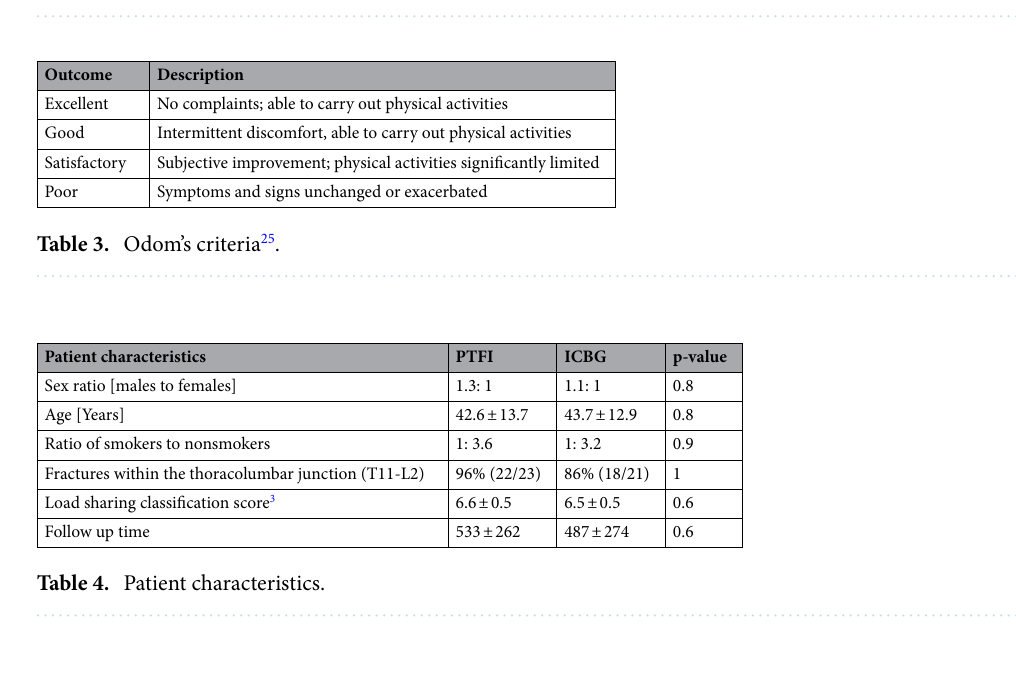
Figure 4. CT volumetry for estimation of the graft volume (ICBG). The CT scan demonstrates how the volume was measured in all three plains.